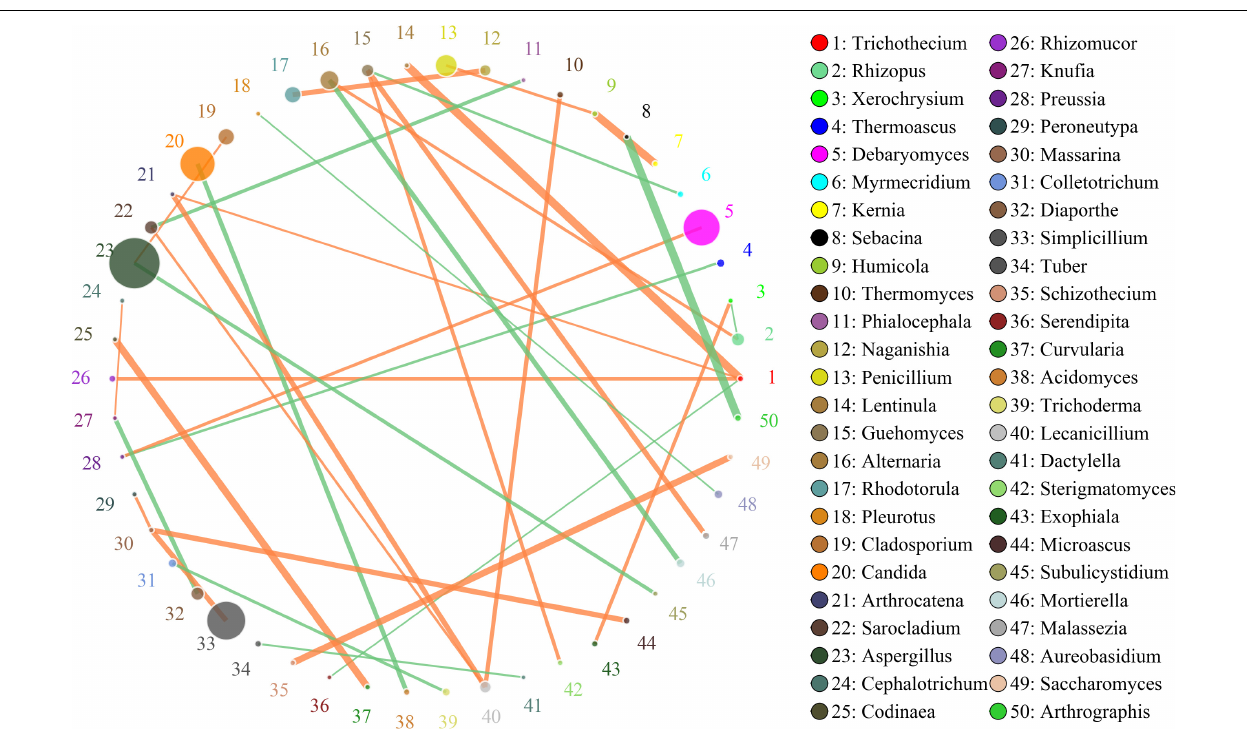
FIGURE 7 | Networks of microbial interaction in the spicy doushen samples. Circle is on behalf of the species, size of the circle represents the abundance. Lines represent the correlation between the two species, line thickness to represent the strength of the correlation, the color of the line: orange represents the positive correlation, green represents the negative